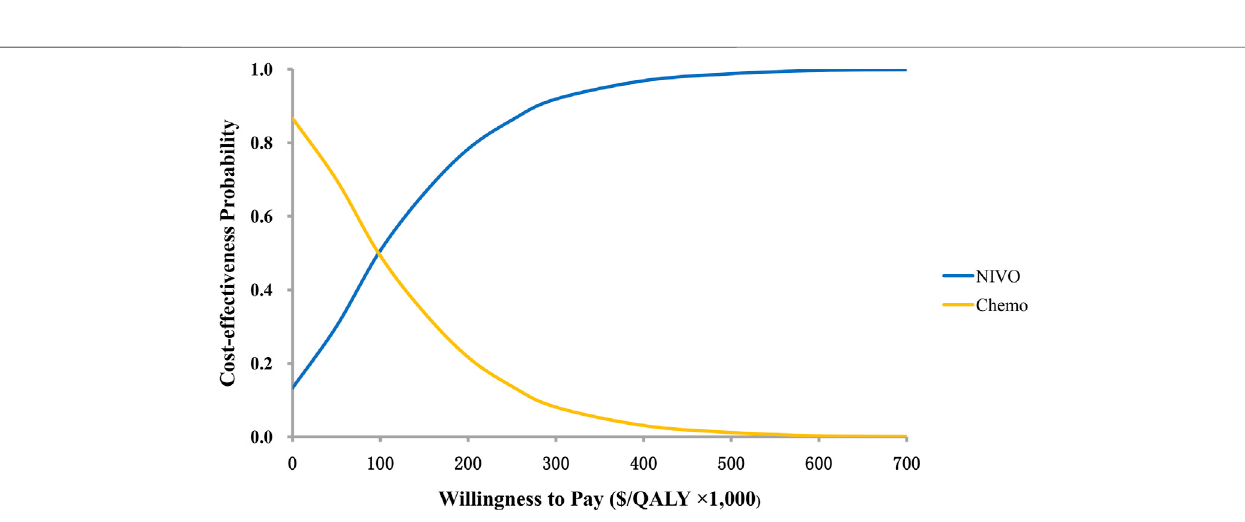
FIGURE 3 | Cost-effectiveness acceptability curves. QALY, quality-adjusted